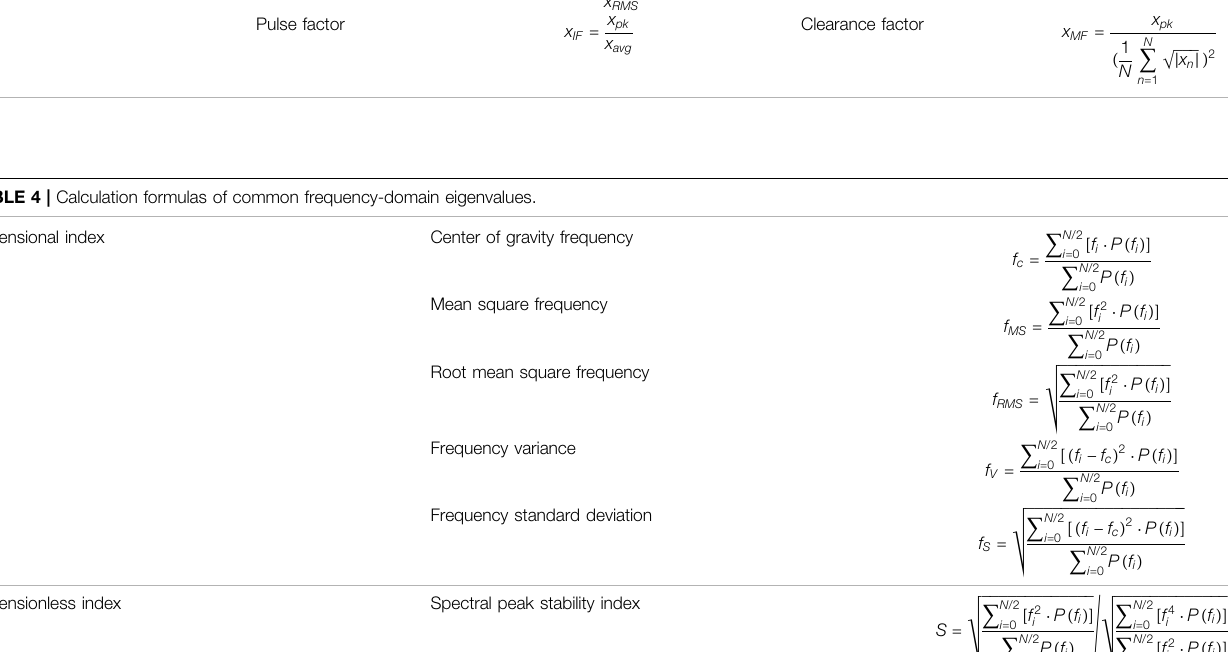
Figure 9 . Select the classi fi cation eigenvalue at the parent node and classify the samples according to set rules. The leaf node represents the classi fi cation result. Since the input eigenvalues in